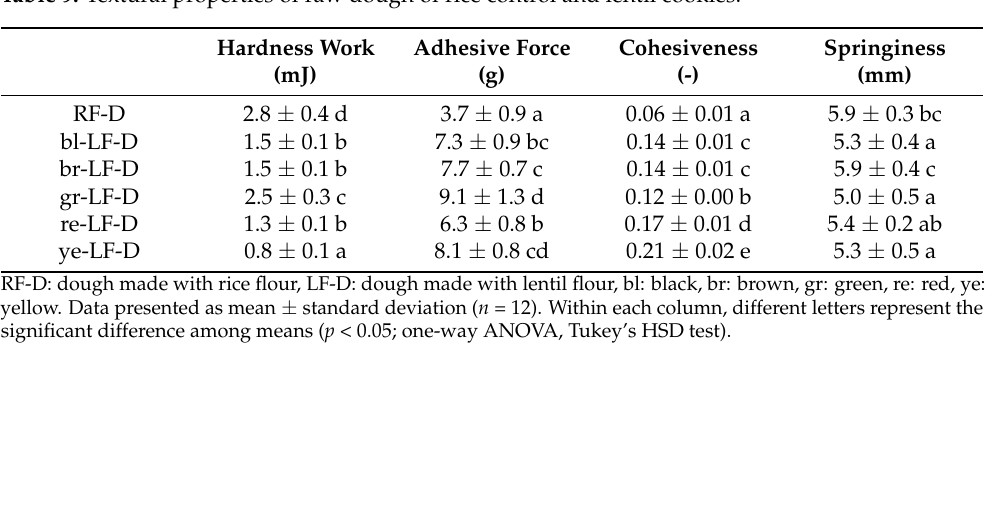
Table 9. Textural properties of raw dough of rice control and lentil